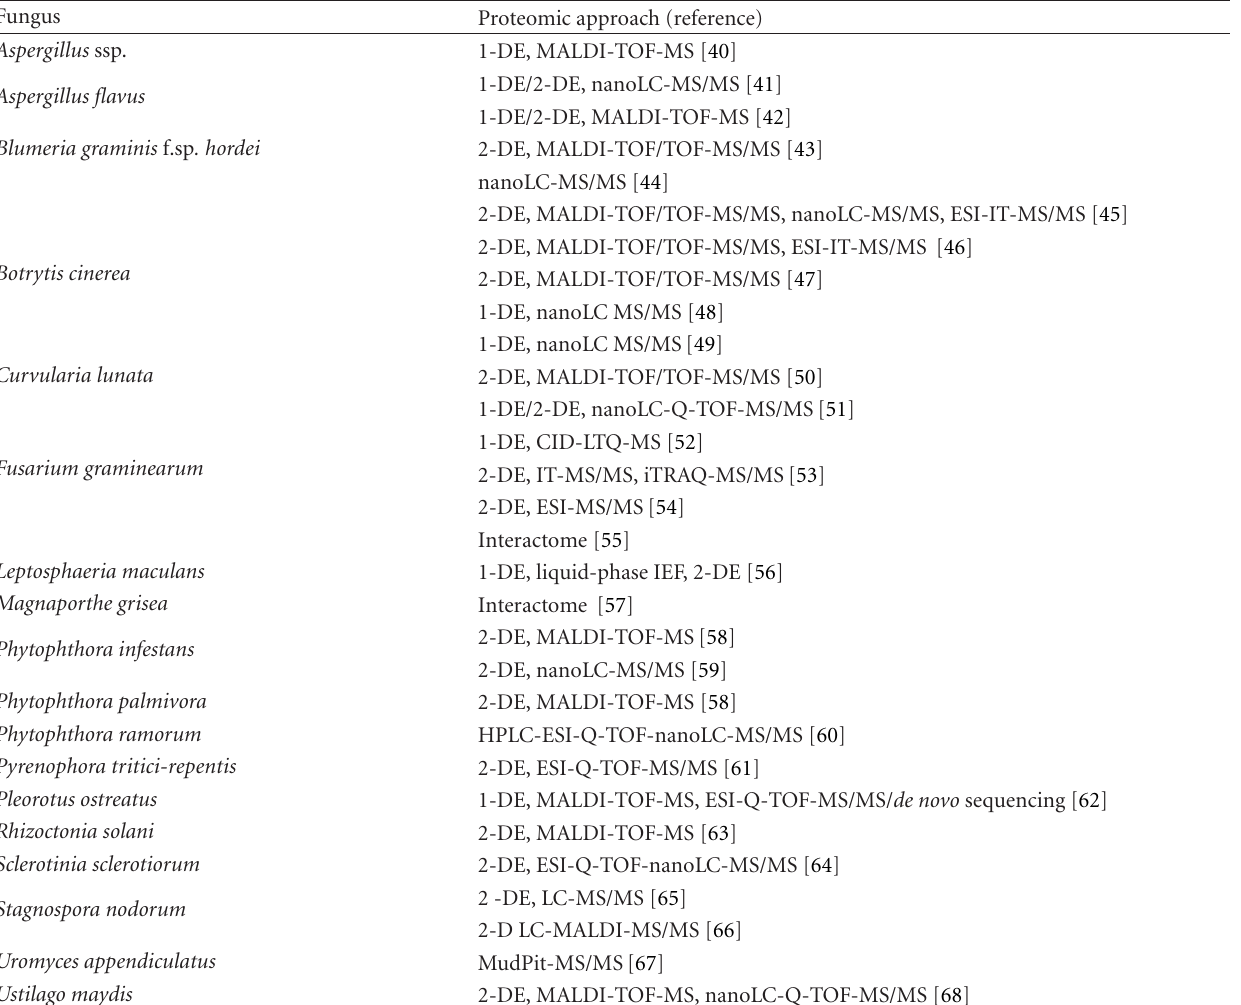
Table 3: Original proteomics papers and reviews published on plant pathogenic